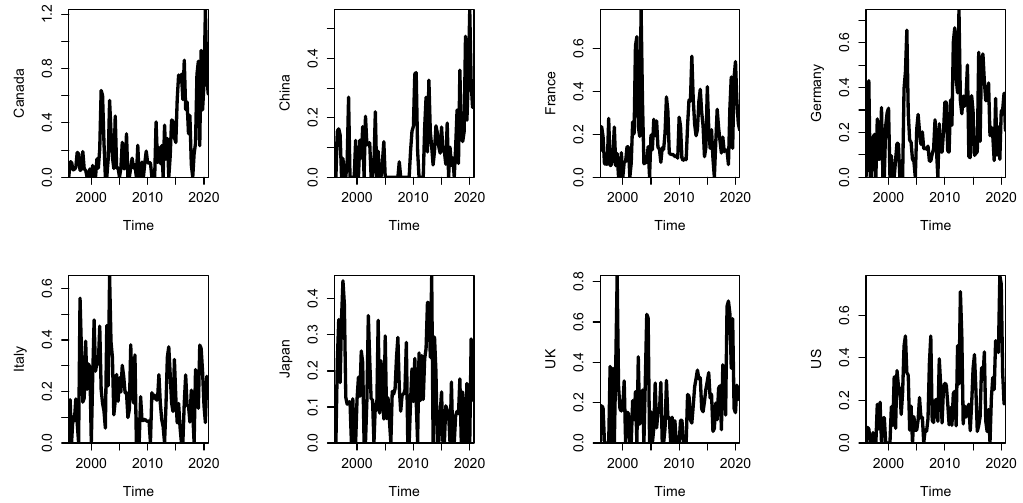
Figure 2. Time series of uncertainty. For better readability, the vertical axes of the panels are not the same for all time series.